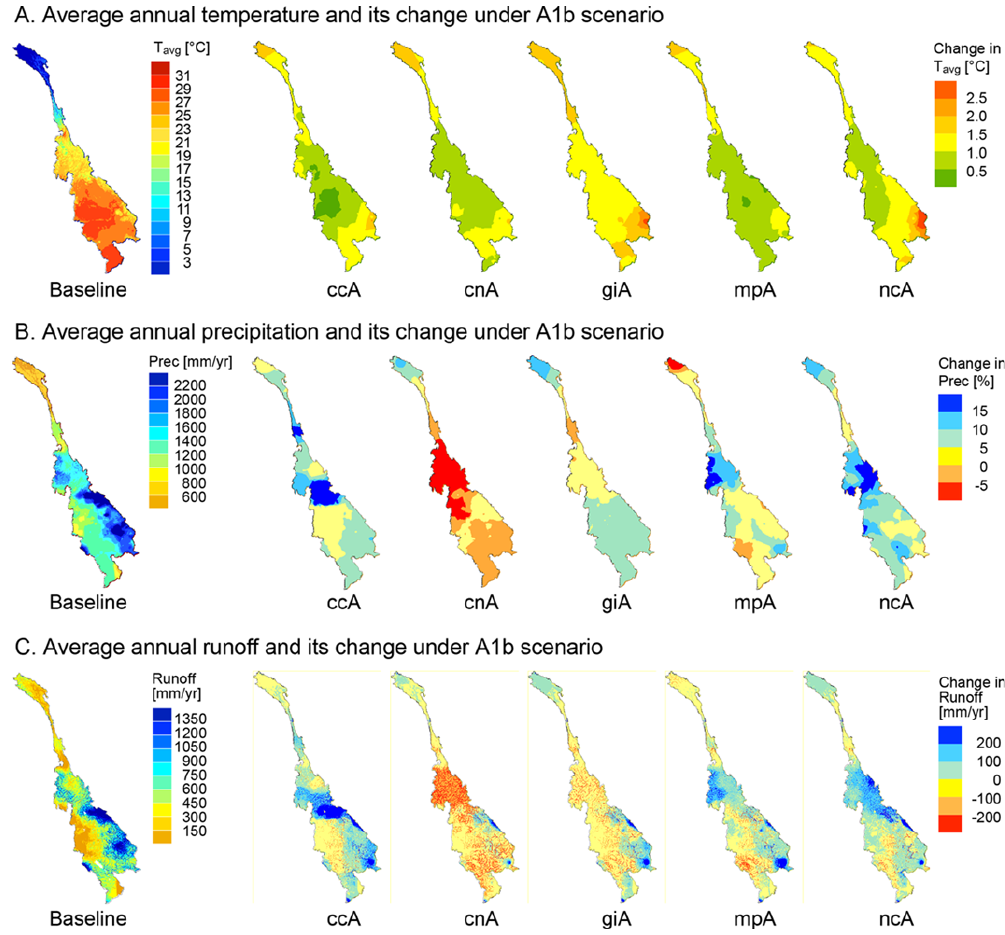
Fig. 3. Baseline results (1982–1992) and impact of climate change (2032–2042) on those under A1b scenario. (A) Average annual temper- ature ( T avg ; ◦ C). (B) Annual precipitation (mmyr − 1 for baseline and % for change). (C) Average annual runoff (mmyr − 1 ). Abbreviations for used GCMs are stated in Table 4.